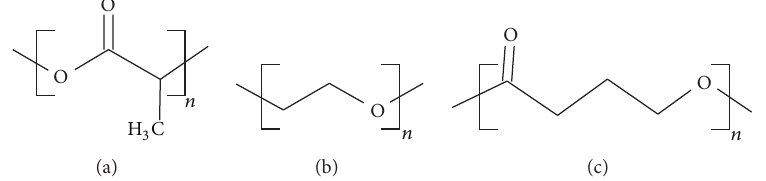
Figure 1: Chemical structure of the polymers used for fiber spinning: (a) PLA, (b) PEO and (c) PCL.